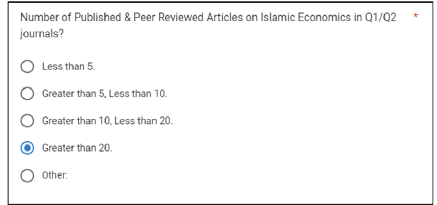
Figure 3: Survey question to identify respondents’ level of expertise.